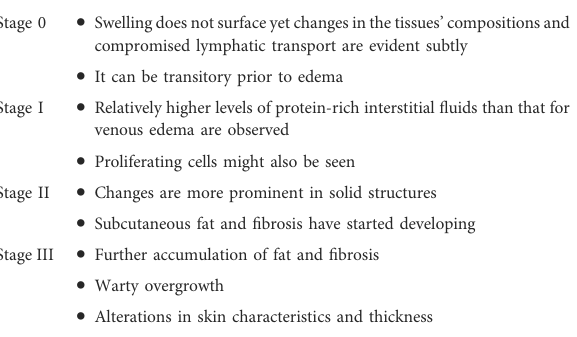
TABLE 1 Description of lymphedema staging. Clinical